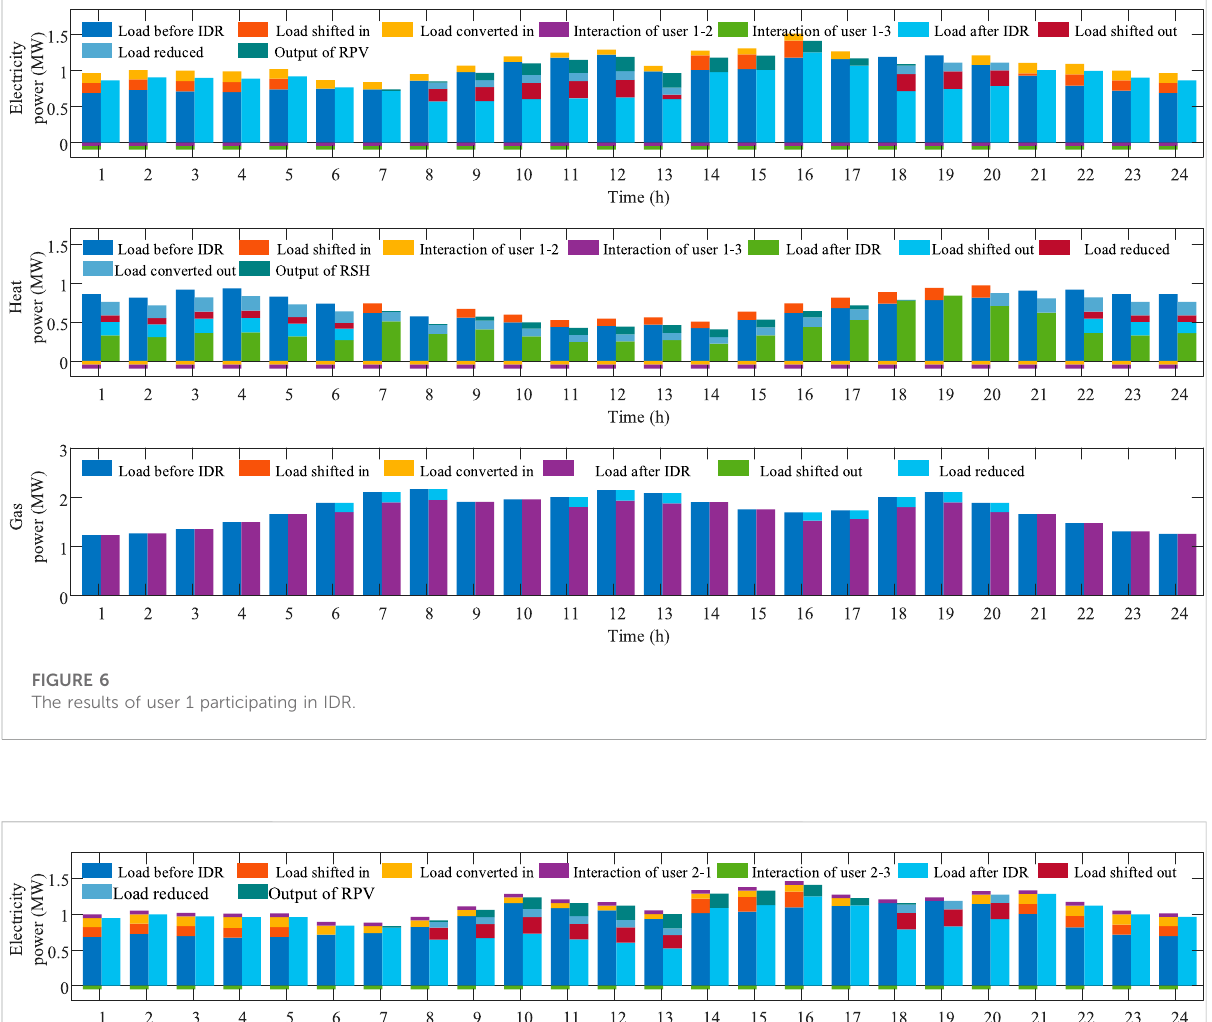
FIGURE 6 The results of user 1 participating in IDR.